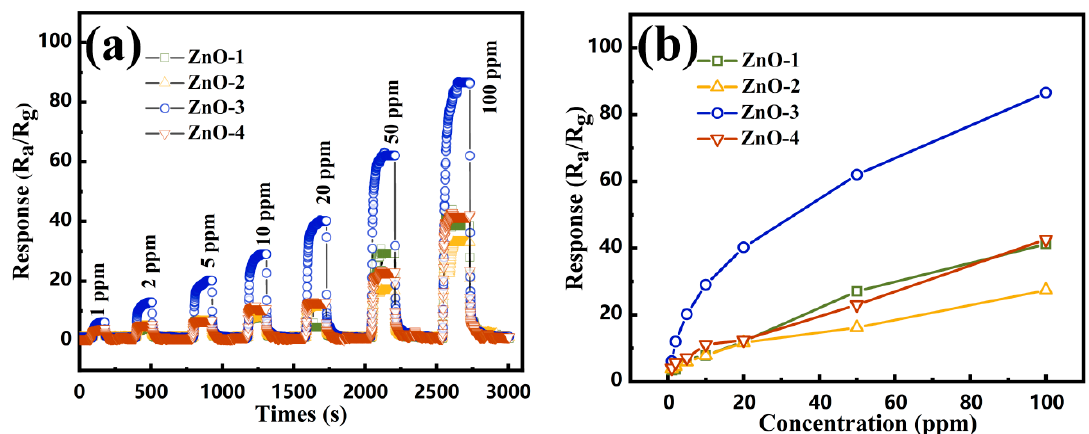
Figure 6. ( a ) Dynamitic curves and ( b ) responses to different concentrations of n -butanol at 340 °C.